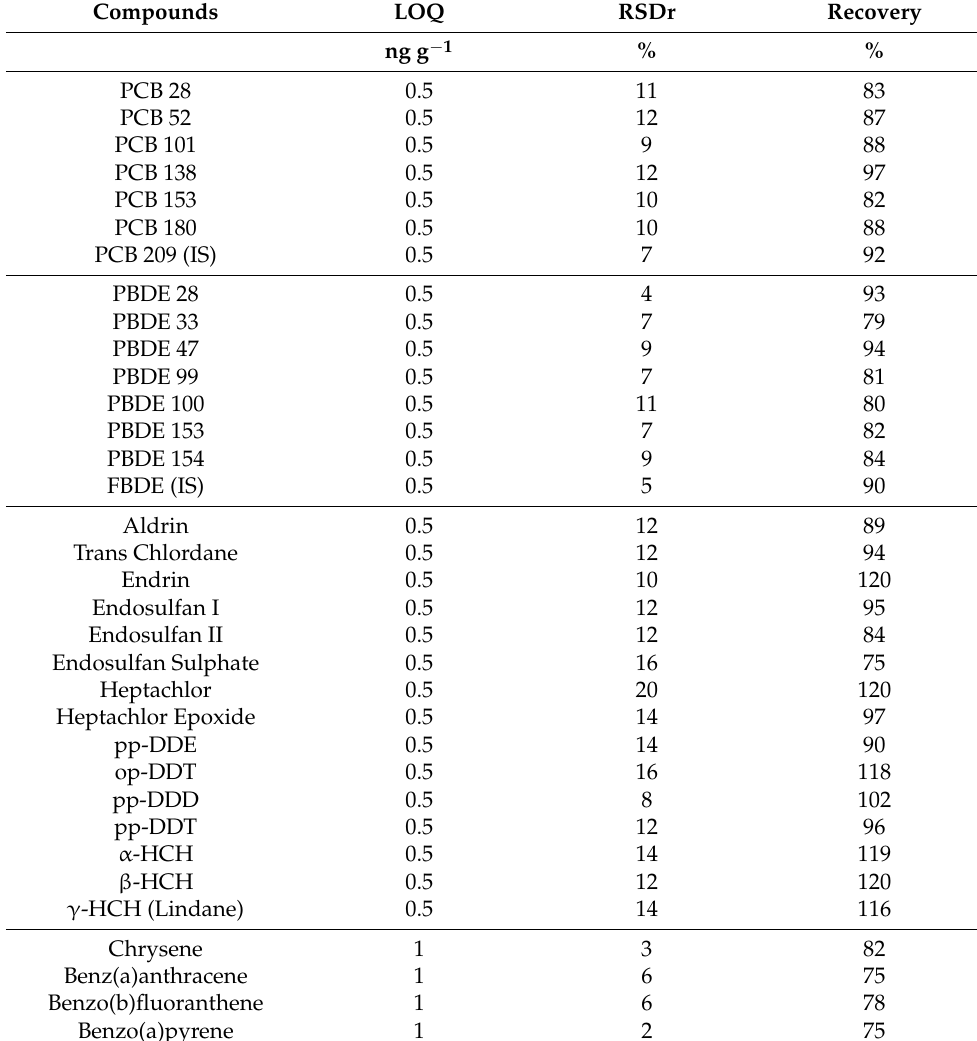
Table 3. LOQs and validation parameters of the analysed compounds.